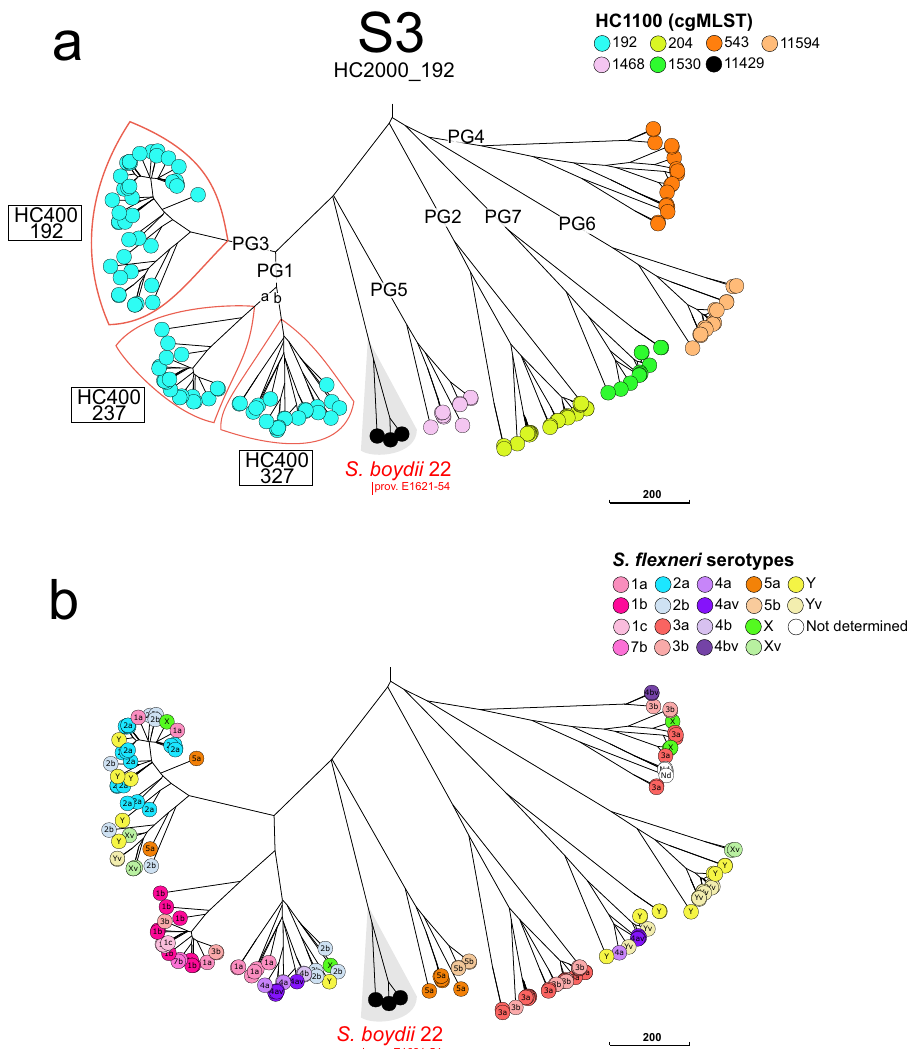
Fig. 4 A NINJA NJ GrapeTree showing the population structure of the Shigella S3 cluster (HC2000_192). This subtree is based on the tree shown in Fig. 1. a The tree nodes are colour-coded by HC1100 data. The S. fl exneri phylogenetic groups (PG) identi fi ed by Connor and coworkers 2 are indicated. Some HC400 clusters are indicated to separate PG3 from PG1. S. boydi 22 (formerly prov. E1621-54) is shown. b The tree nodes are colour-coded by S. fl exneri serotype. The scale bar indicates the number of cgMLST allelic